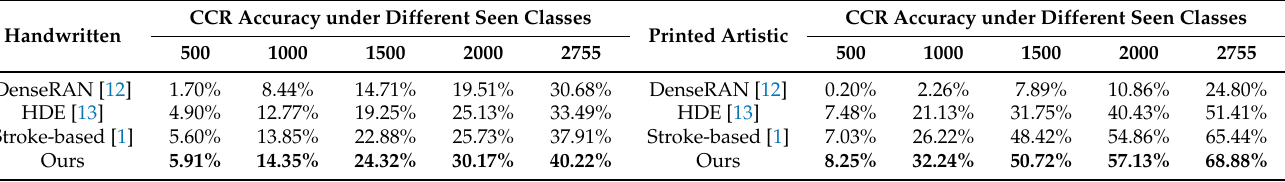
Table 1. The results of zero-shot recognition with various approaches. Our model utilize the SAE based on ResNet and Transformer pre-trained on the second form of data sets.